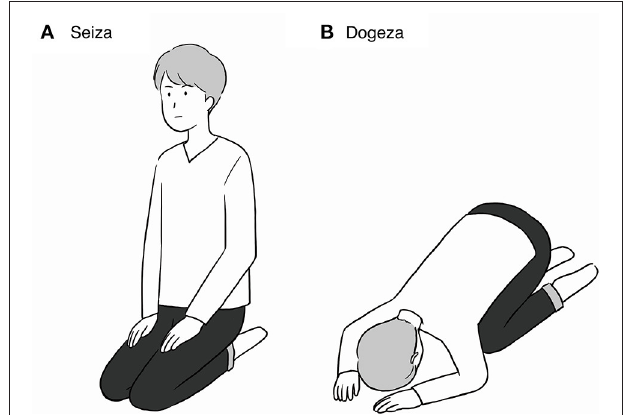
FIGURE 1 | Cartoons are also a part of Japanese culture. (A) Seiza is a style of Japanese formal sitting that involves kneeling on the floor. (B) Dogeza is a form of bowing while sitting in a kneeling position with the forehead touching the